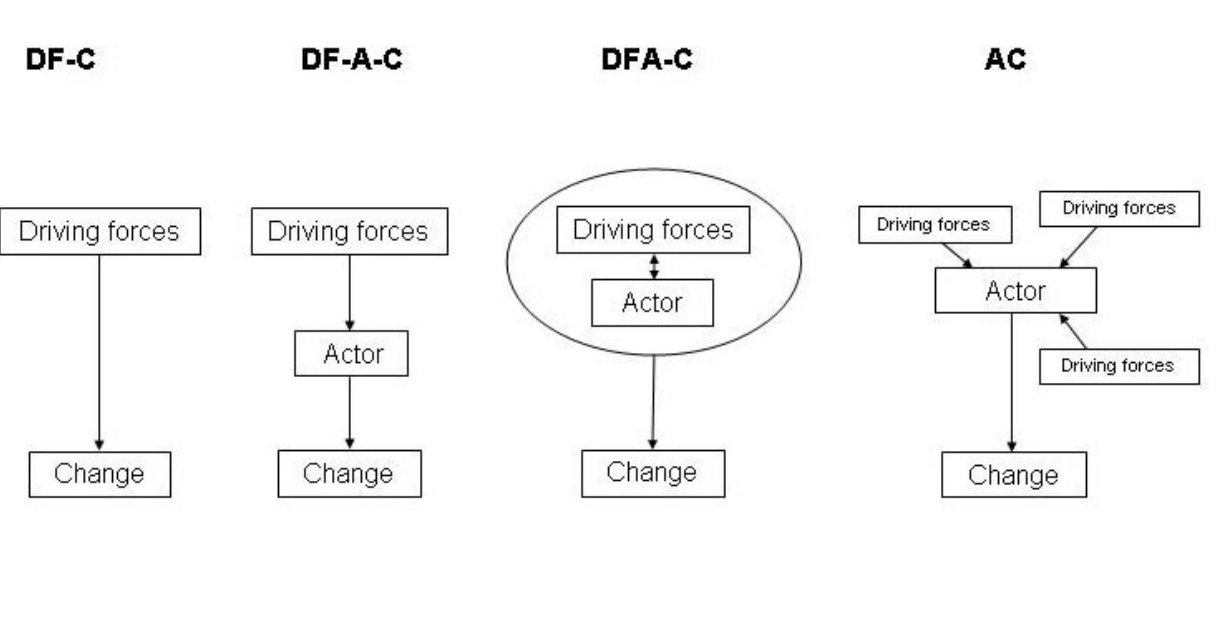
Fig. 1 . Four conceptual models for linking land change (C) with driving forces (DF) and actors (A) in land change studies. The models are labeled based on their characteristic components and links. To keep the diagram simple, arrows indicate only the main directions of